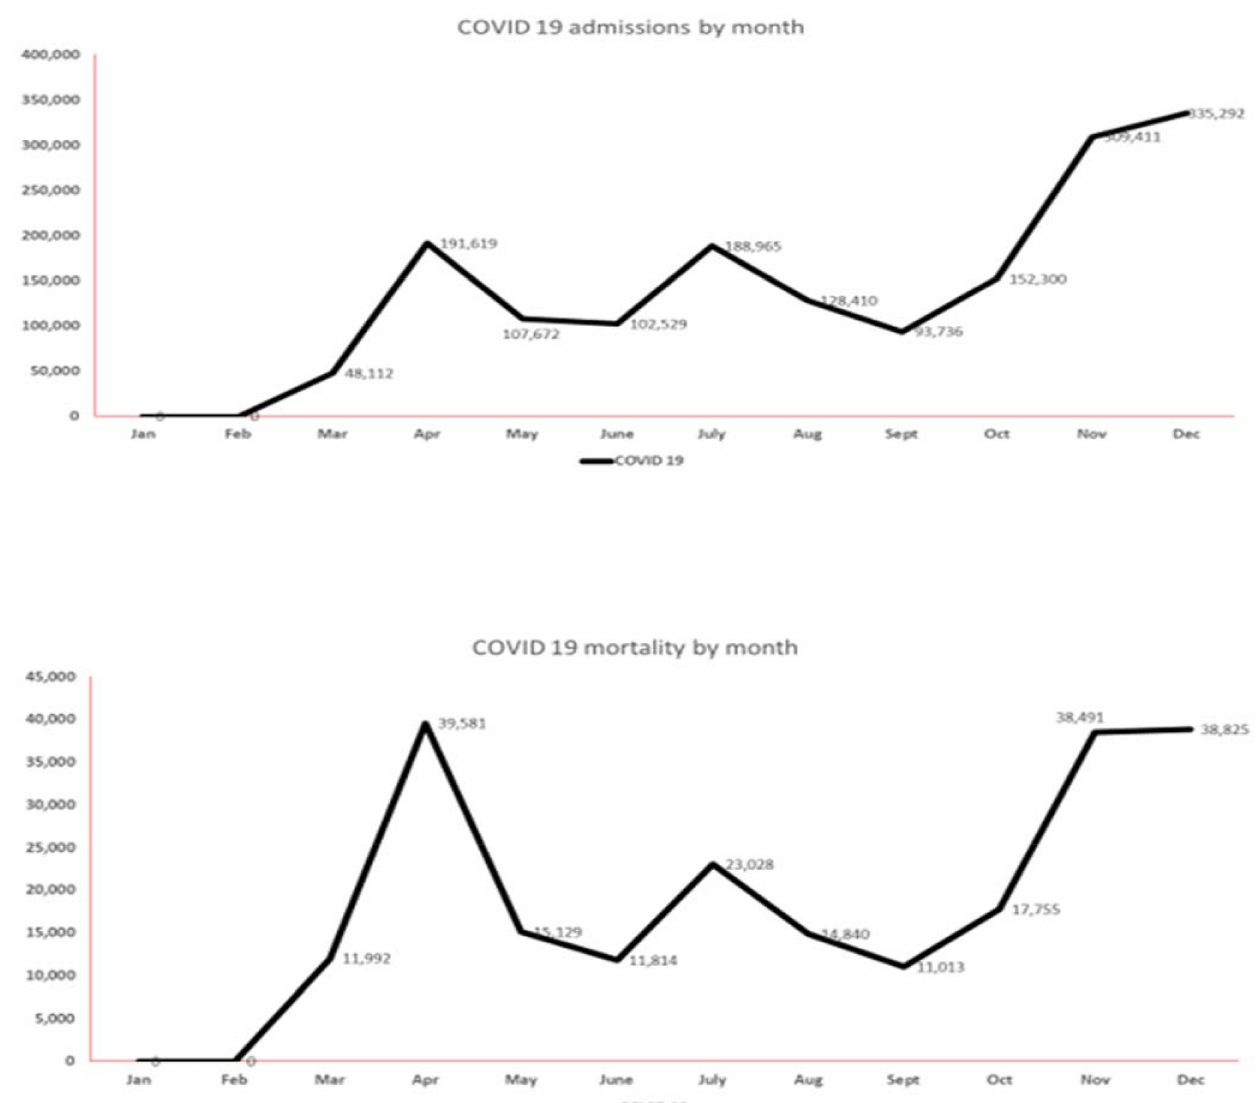
Figure 5. Monthly variations in the amount of COVID-19 activity (hospitalizations at top, mortality at bottom) during